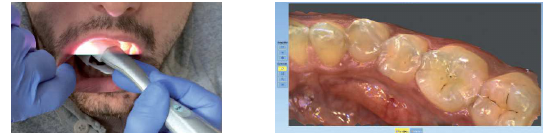
Figure 7 : Medicis 2D disparity map obtained with the same parameters as the one used by Rosu et al and detailed in Figure 5, except the exploration radius and the initial disparity that are kept to the default values (4 for the exploration radius and 0 for the initial disparity). The results are far better than the published ones.